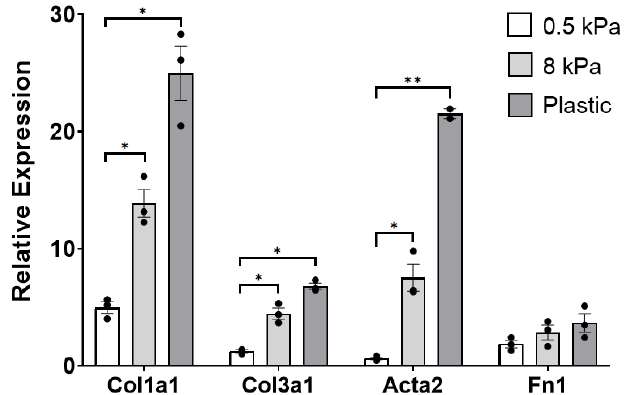
Figure A1. Mean ± standard errors of the mean of Col1a1 , Col3a1 , Acta2 , and Fn1 gene expression of cells seeded on Cytosoft ® plates. Effects of stiffness on PAAF gene expression relative to 18S ribosomal RNA. Significant effect of stiffness (* p < 0.05 and ** p < 0.0001) by one-way analysis of variance (ANOVA) compared with gene expression at 0.5 kPa.